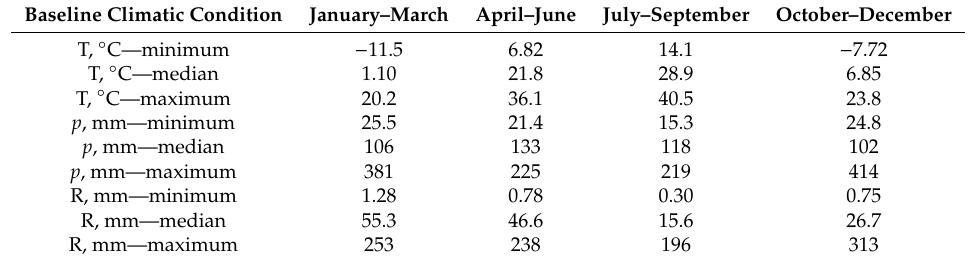
Table 1. Summary statistics for baseline (1981–1999) climatic conditions for average monthly temperature (T), precipitation ( p ), and runo ff (R) for each season, for the 374 National Park Service parks. Baseline Climatic Condition